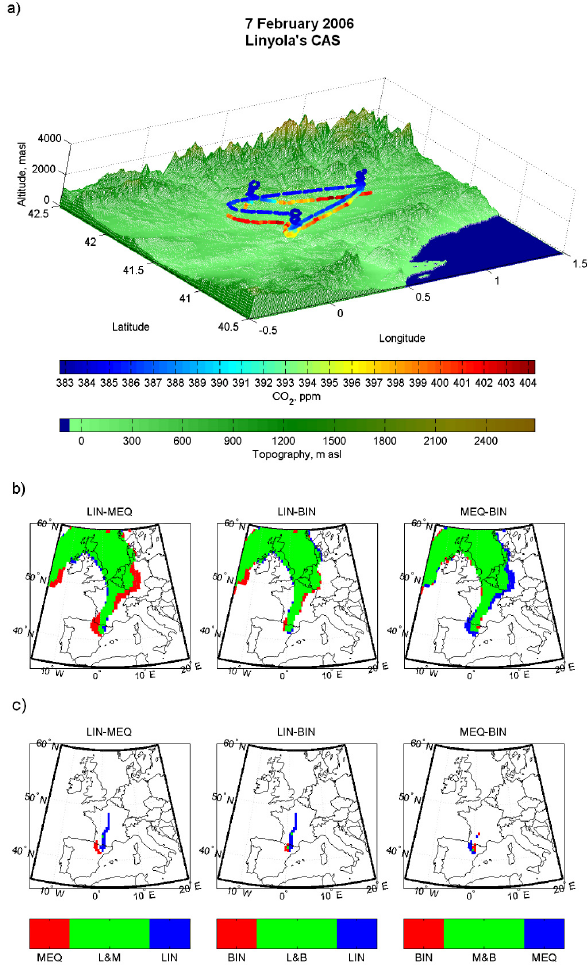
Fig. 4. (a) CO 2 mixing ratios measured during the flight on 7 February 2006 superimposed to the topography of the region extracted from GTOPO30 global digital elevation model (DEM) from the US Geological Survey’s EROS Data Center in Sioux Falls, South Dakota (http://edc.usgs.gov/). (b) Pair-by-pair quali- tative differences of the Potential Surface Influence (PSI) between LIN, MEQ and BIN for the simulation started at 7 February 2006 12:00:00UTC. (c) Pair-by-pair qualitative differences of the Re- gional Potential Surface Influence (RPSI) between LIN, MEQ and BIN for the simulation started at 7 February 2006,